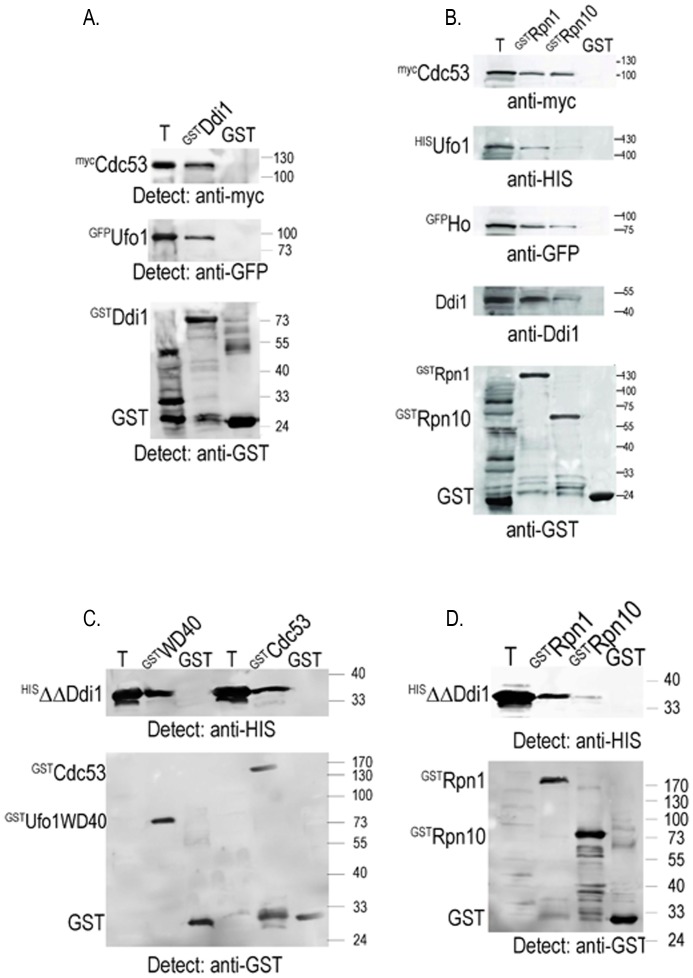
Immobilized Ddi1 and Rpn1 reconstitute SCFUfo1 complexes in vitro.A. GSTDdi1 or control GST on GSH beads were incubated with yeast extract from cells that produced mycCdc53 and GFPUfo1. Analysis was by Western blotting with anti-myc, anti-GFP, and anti-GST antibodies. T represents 10% of the yeast extract with which the beads were incubated. B. GSTRpn1, GSTRpn10, or GST beads were incubated with yeast extract from cells that produced mycCdc53 and GFPHo mixed with bacterial lysate with recombinant HISUfo1. The bead fraction was analysed by Western blotting with anti-myc, anti-HIS, anti-GFP, anti-Ddi1, and anti-GST antibodies. T represents 10% of the yeast extract incubated with the beads. C. GSTUfo1 WD40 domain, GSTCdc53, or control GST on GSH beads were incubated with bacterial lysate from cells that produced recombinant HISΔΔDdi1. The bead fraction was analysed by Western blotting with anti-HIS and with anti-GST antibodies as indicated. T is 10% of the HISΔΔDdi1 bacterial lysate incubated with the beads. D. The HISΔΔDdi1 bacterial lysate was incubated with GSTRpn1, GSTRpn10, or GST beads and analysed as above.